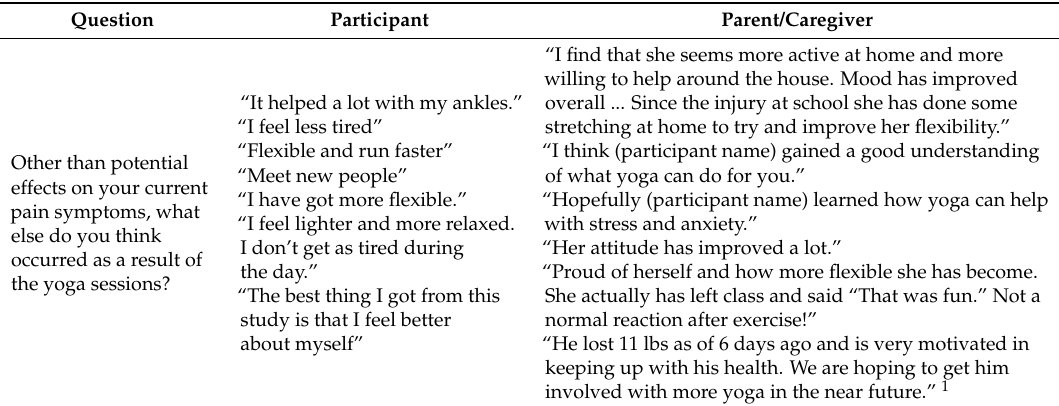
Table 4. Qualitative responses from participants and parents about the yoga